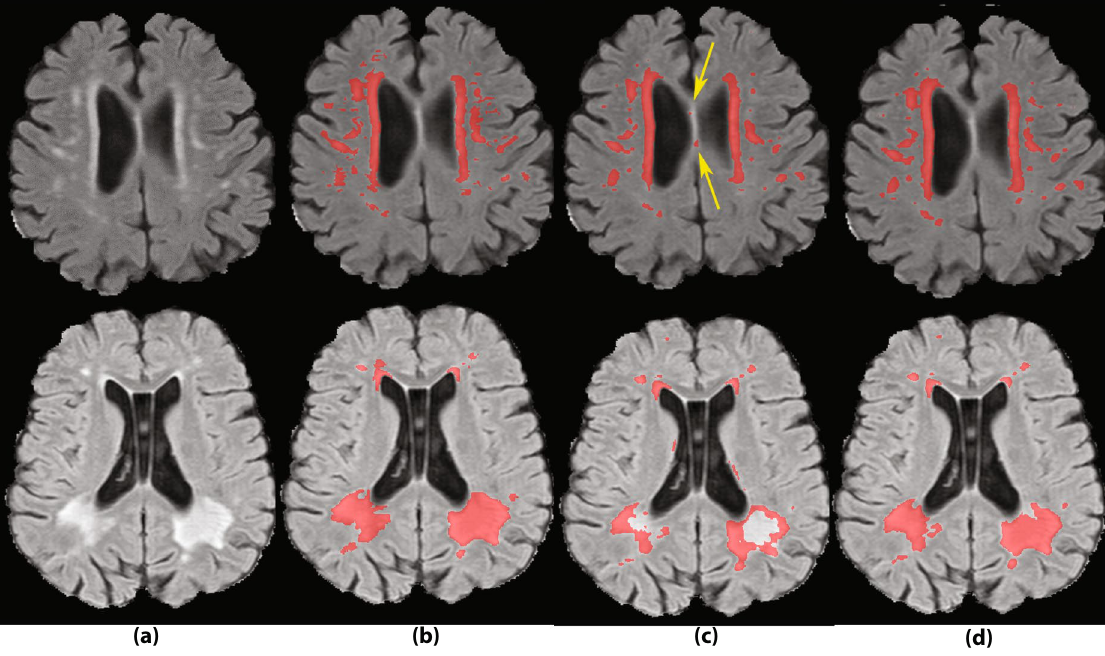
Figure 6. Two sample cases of segmentation improvement by adding location information to the network. ( a ) FLAIR images without annotations. ( b ) Segmentation by human observer 1. ( c ) Segmentation by SS method. ( d ) Segmentation by MSWS + Loc method.